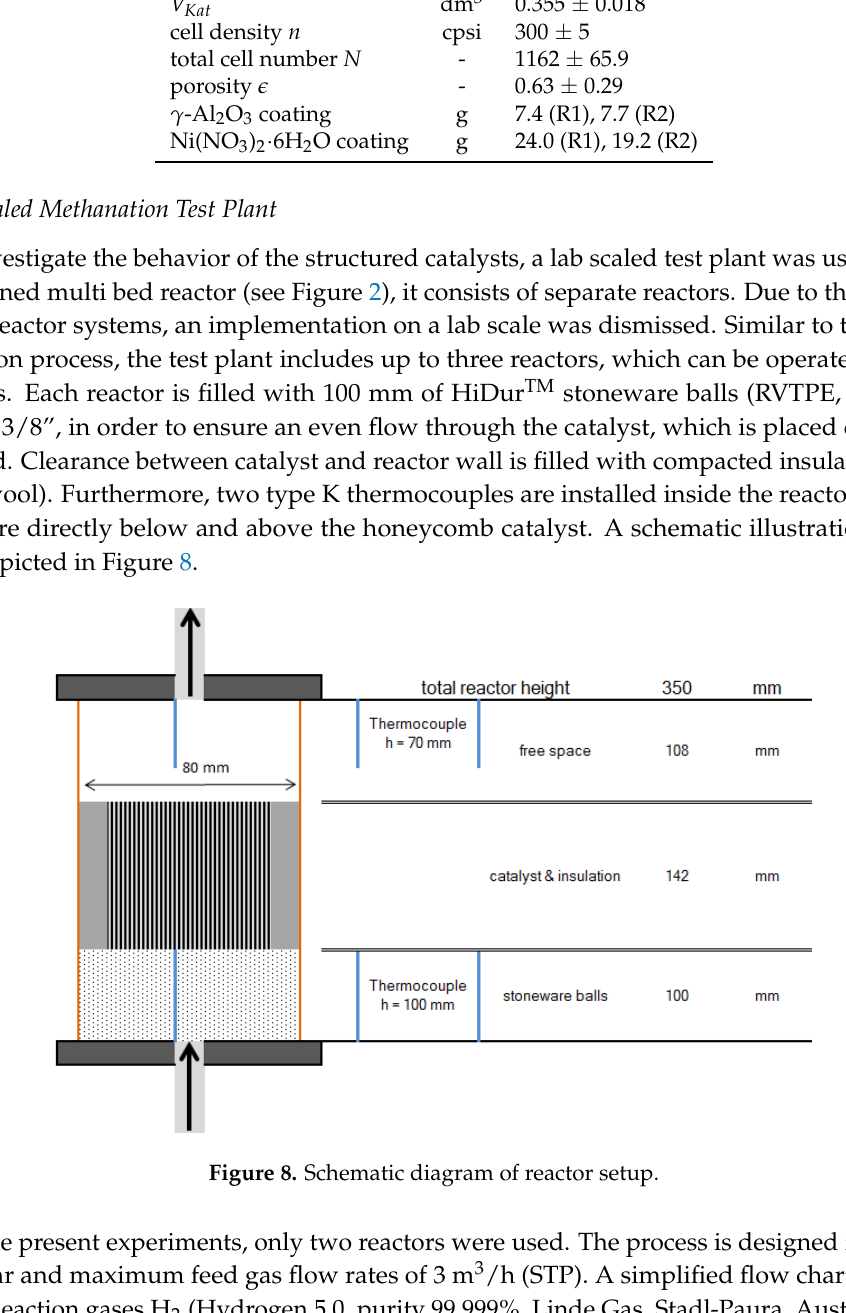
Figure 9. Reaction gases H 2 (Hydrogen 5.0, purity 99.999%, Linde Gas, Stadl-Paura, Austria) and CO 2 (BIOGON R (cid:13) C, E290, purity 99.7%, Linde Gas, Stadl-Paura, Austria) are charged from gas bottles